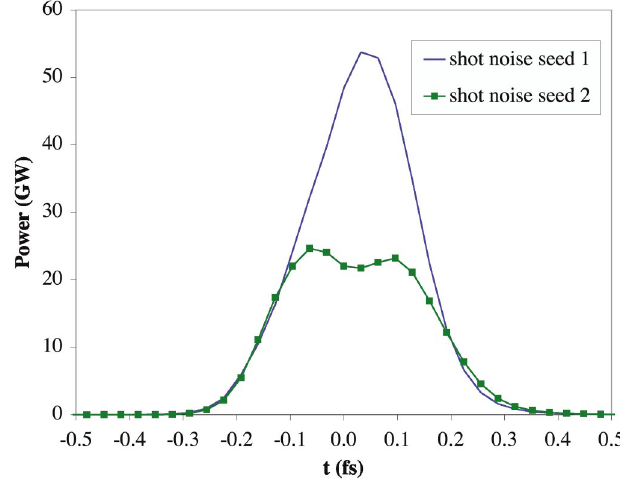
FIG. 11. (Color) Time dependence of the radiation power for the central density spike, resulting from two different random seeds for shot noise.